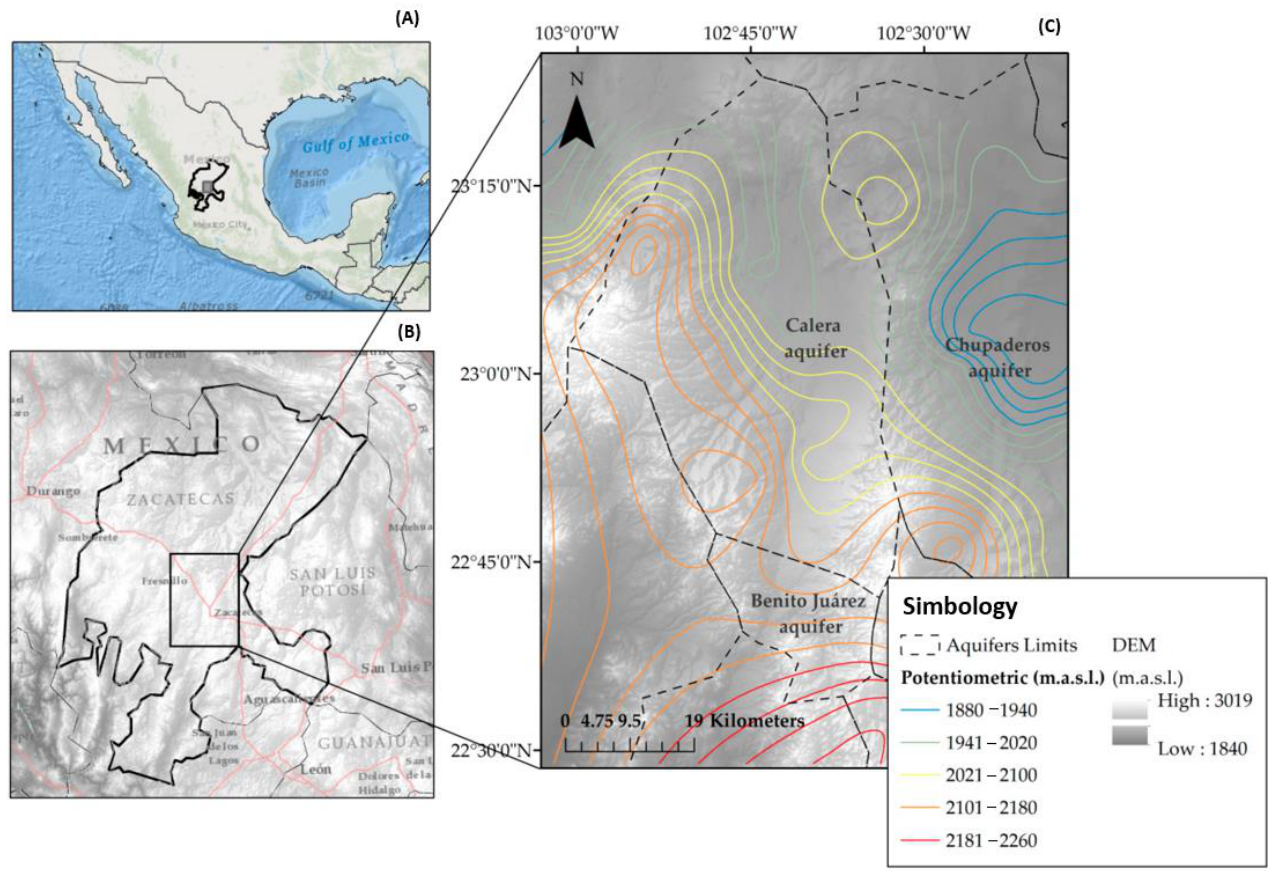
Figure 1. ( A ) Study area: the state of Zacatecas in Mexico. ( B ) Digital elevation model (DEM) with the territorial extension of the Calera. ( C ) Benito Juárez and Chupaderos administrative aquifers.